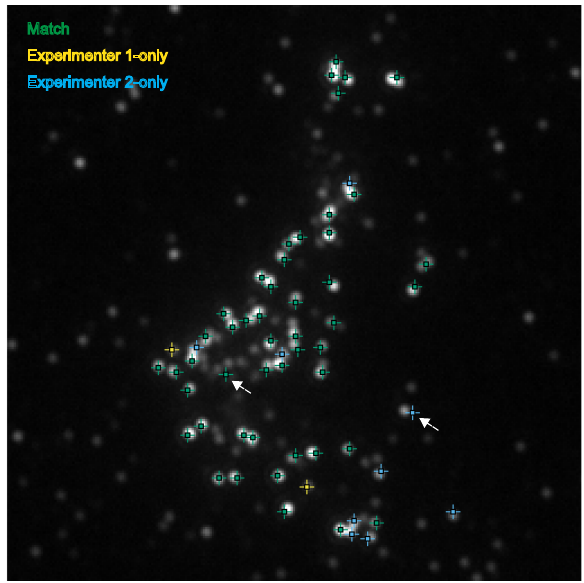
Figure 2. Comparison of focus assignments between experimenters. An example image shows matches (within 8 pixels) of two experimenters in green using the position of experimenter P1. Unmatched foci that were selected only by experimenter P1 are shown in yellow and unmatched foci selected only by experimenter P2 are indicated in blue. The Jaccard score for this comparison was 0.81. Only spots within the DAPI stained region were extracted for analysis. Arrows indicate examples where experimenters have clicked a short distance from a